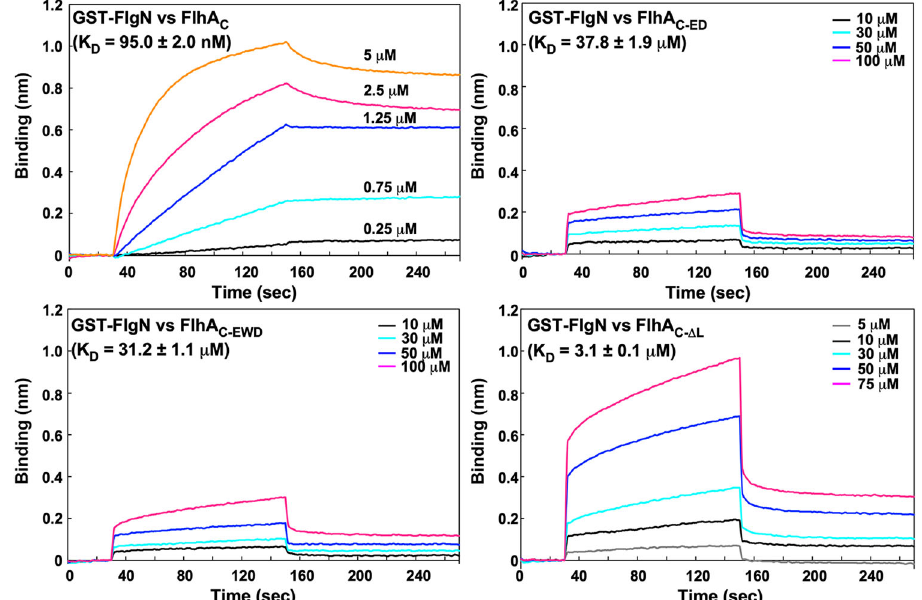
Fig. 7 Effect of FlhA linker mutations on the interaction of FlhA C with FlgN. BLI pro fi les were obtained from the FlhA C – FlgN interaction (upper, left panel), the FlhA C-ED – FlgN interaction (upper, right panel), the FlhA C-EWD – FlgN interaction (lower, left panel) and the FlhA C- Δ L – FlgN interaction (lower, right panel). GST-FlgN was immobilized to an anti-GST sensor tip. The sensor tip was then dipped into FlhA C , FlhA C-ED , FlhA C-EWD , or FlhA C- Δ L of various concentrations to measure association before being dipped into the kinetic buffer to measure dissociation. Three independent measurements were carried out. All experiments were performed at 25